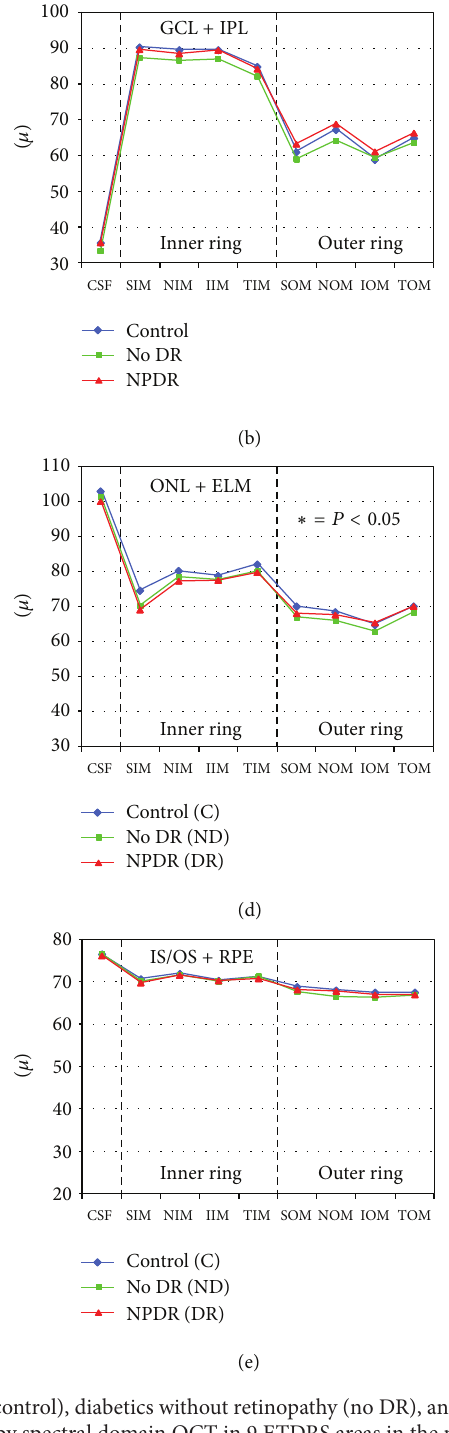
Figure 2: Graphs showing specific retinal layer thickness in normal subjects (control), diabetics without retinopathy (no DR), and diabetics with nonproliferative diabetic retinopathy (NPDR) determined automatically by spectral domain OCT in 9 ETDRS areas in the macula. (a) Inner limiting membrane + nerve fibre layer (ILM + RNFL); (b) ganglion cell layer + inner plexiform layer (GCL + IPL); (c) inner nuclear layer + outer plexiform layer (INL + OPL); (d) outer nuclear layer + external limiting membrane (ONL + ELM); and (e) inner segment/outer segment photoreceptor layer + retinal pigment epithelium (IS/OS + RPE). ( ∗ ) indicates statistically significant values; CSF: central subfield thickness; SIM: superior inner quadrant in the macula; NIM: nasal inner quadrant; IIM: inferior inner quadrant; TIM: temporal inner quadrant; SOM: superior outer quadrant in the macula; NOM: nasal outer quadrant; IOM: inferior outer quadrant; TOM: temporal outer